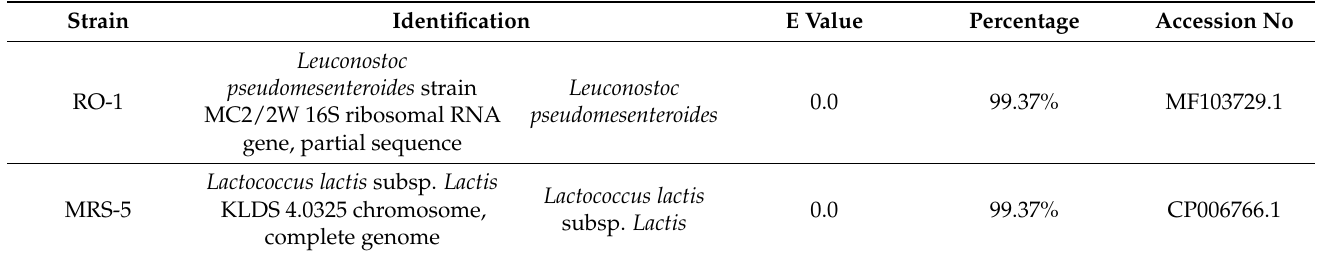
Table 5. Sequencing results of selected strains after amplification of part of the 16S rRNA gene and comparison with the BLAST